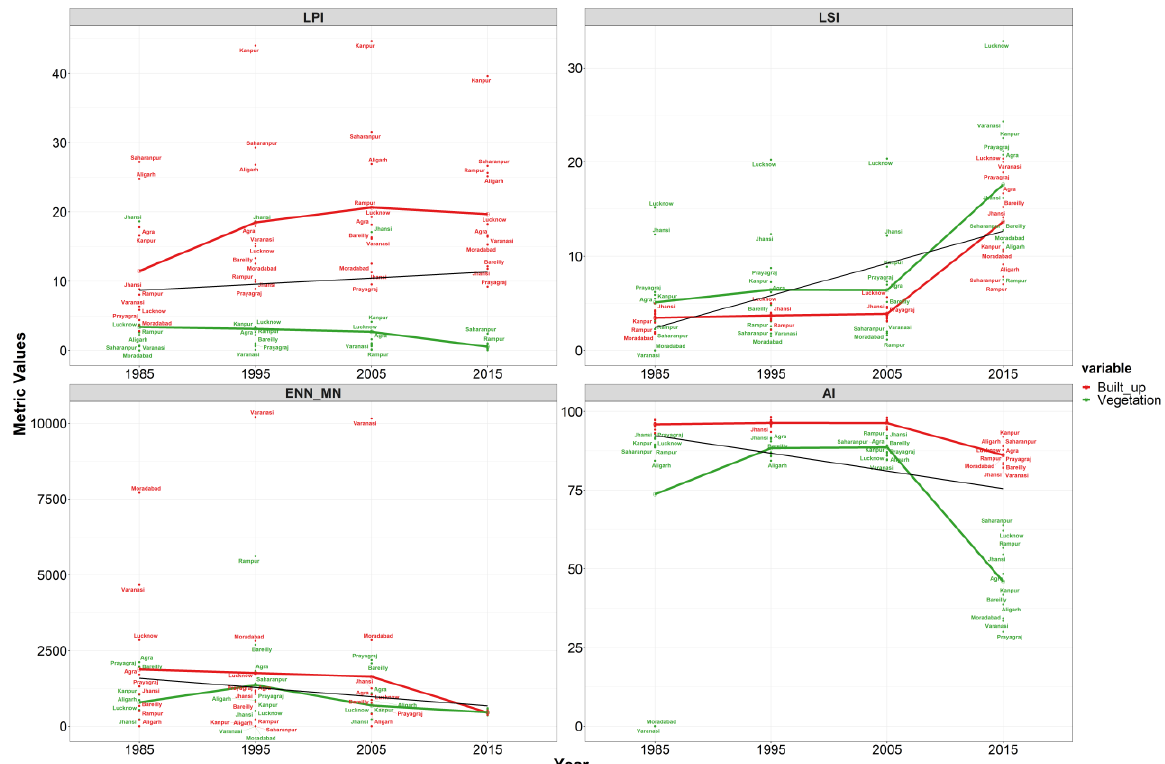
Figure 4. Trend of landscape metrics for Built-up and Vegetation patches across 11smart cities of Uttar Pradesh over